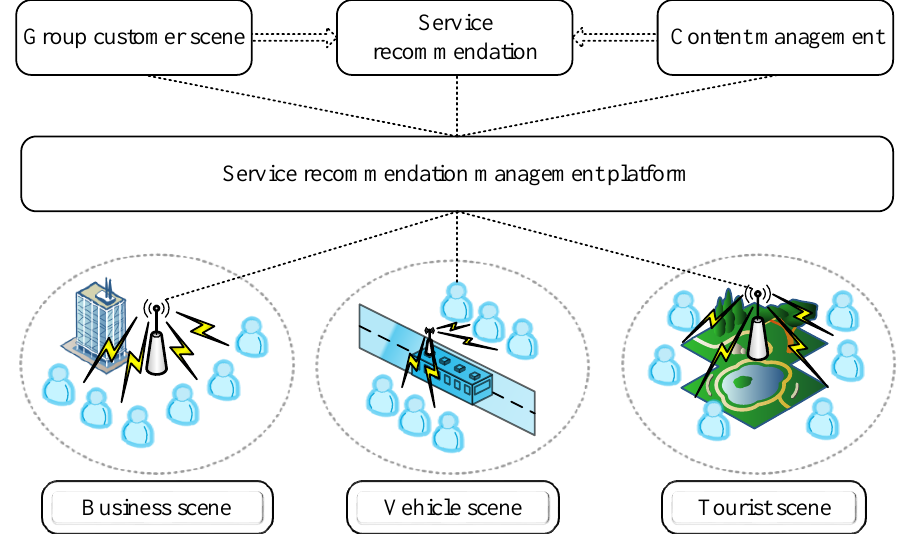
Figure 1. The recommended service application scenarios.